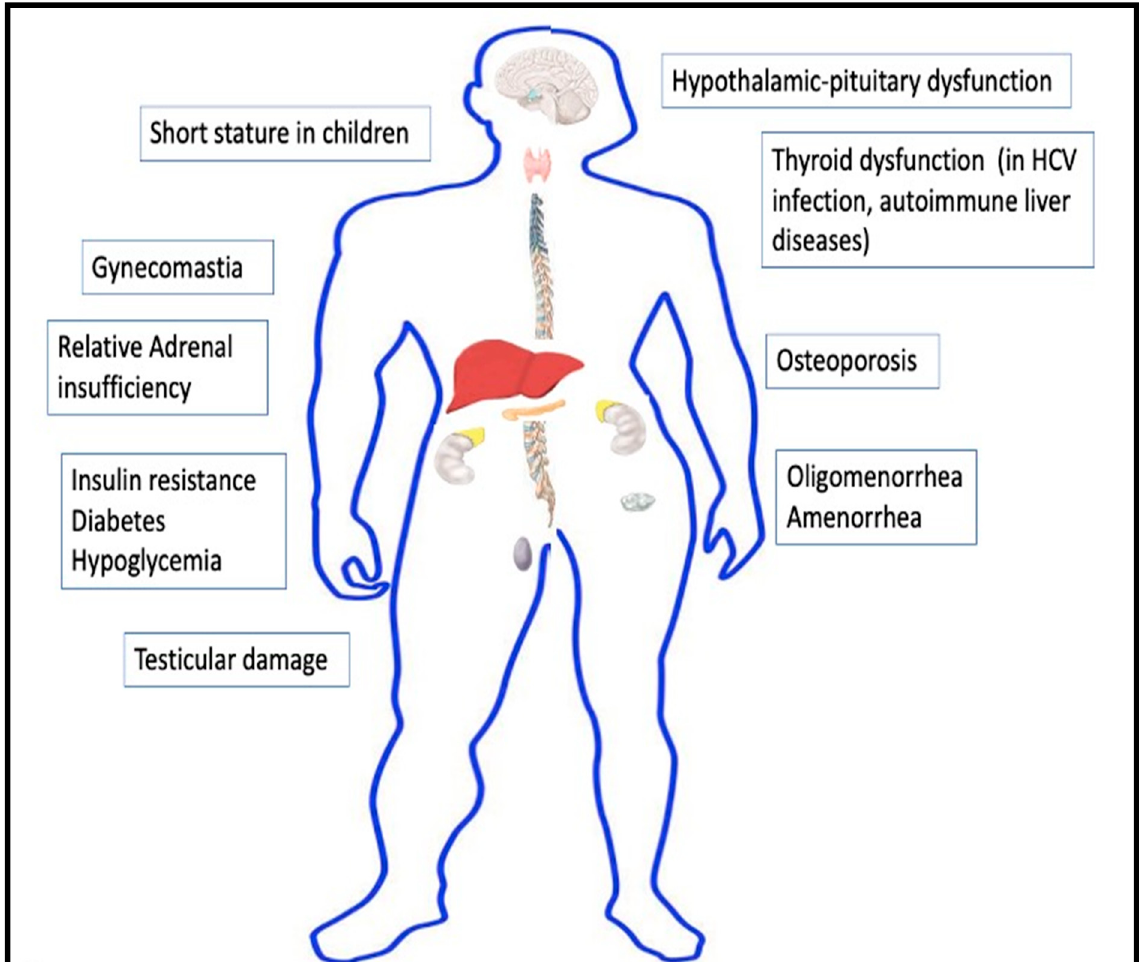
Figure 1. Endocrine manifestations of cirrhosis.